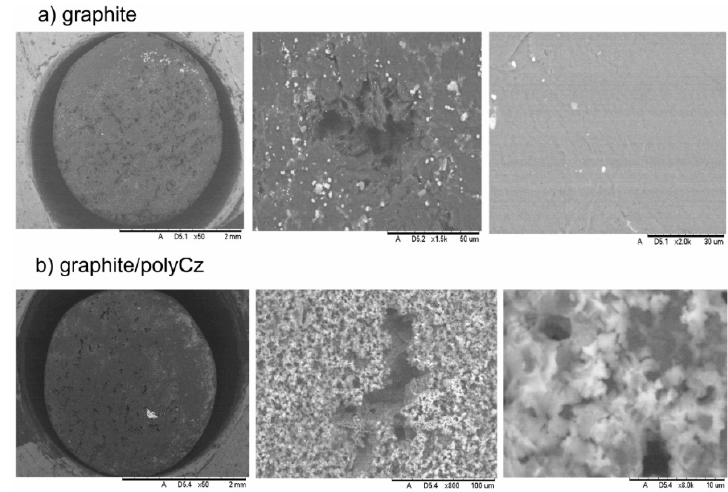
Figure 3. Scanning electron microscopy images of surfaces of ( a ) bare graphite; ( b ) graphite / polyCz electrodes are presented. Scales are 2 mm, 50 μm, 30 μm, 2 mm, 100 μm, and 10 μm, respectively.